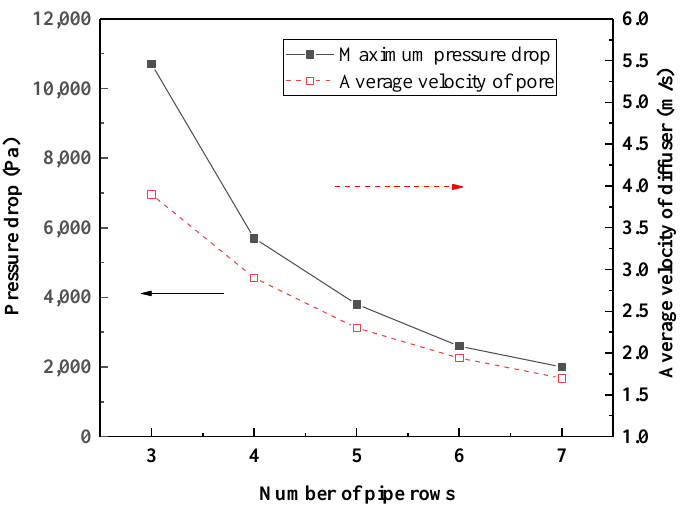
Figure 4. Maximum pressure drop within the water diffuser and average velocity of the perforated pore under different number of trunk pipe rows.